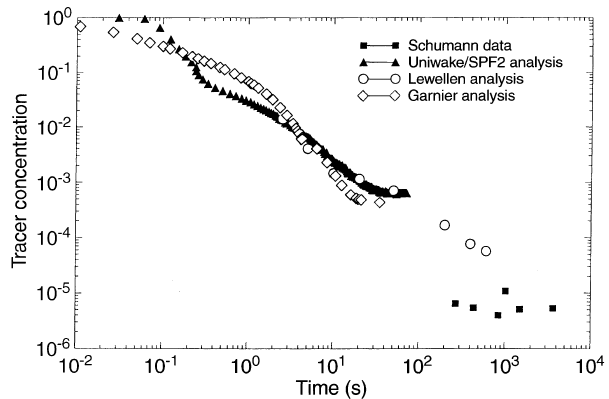
Fig. 10. Axial tracer concentration plots of inboard engine centreline of B-747. Comparison of three theoretical analyses with the Schumann data: UNIWAKE analysis, Lewellen analysis and the